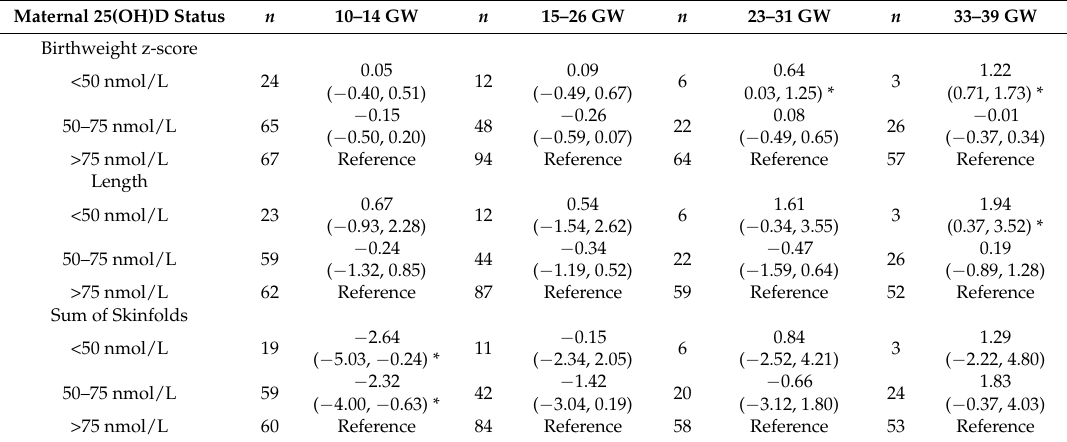
Table 3. Longitudinal associations of maternal total 25(OH)D (nmol/L) and birthweight z-score, length (cm), and sum of skinfolds (mm) among women with a normal prepregnancy BMI 1 . Maternal 25(OH)D